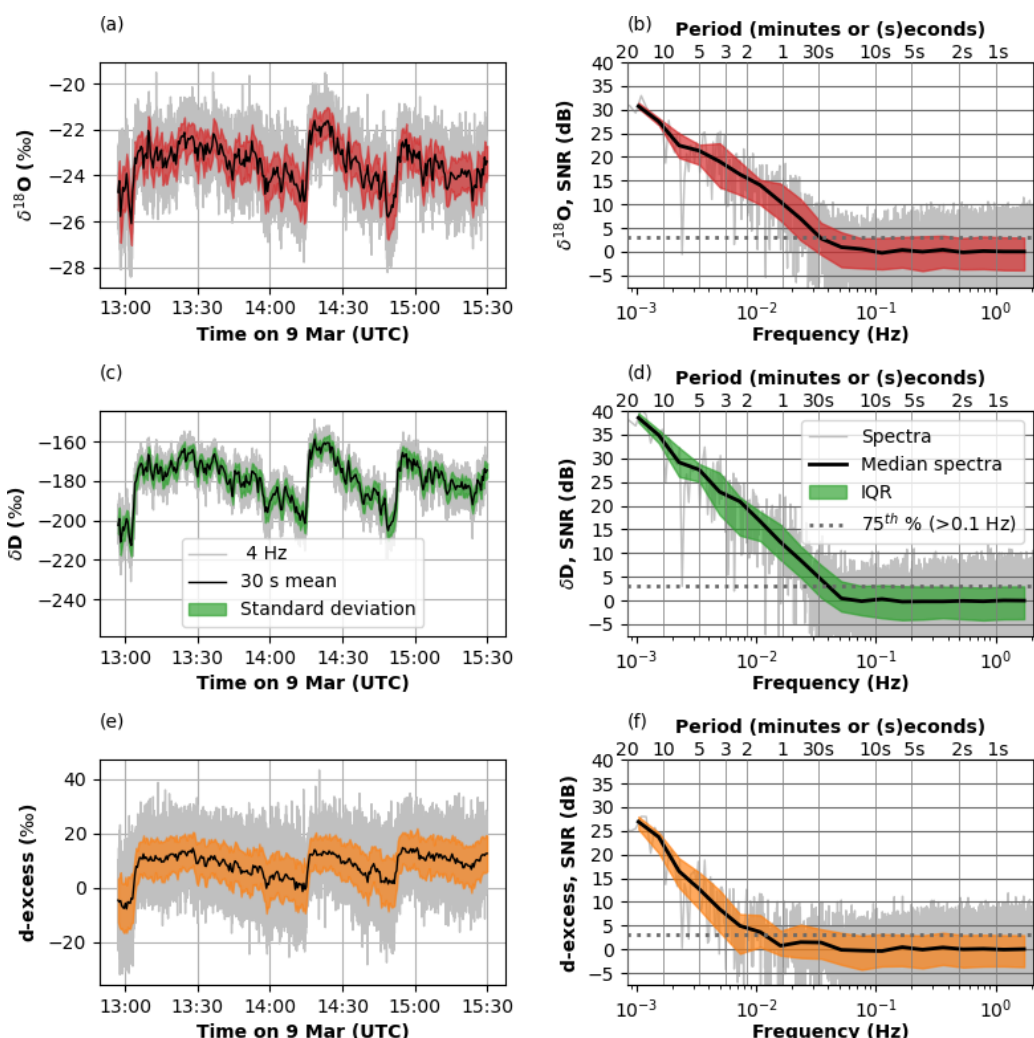
Figure 9. Resolving isotopic signals during the profiling period on 9 March 2020, from 12:57 to 15:30UTC. (a) The 4Hz δ 18 O signal (gray), with the 30s mean (thick black) and standard deviation of the same (colored shading). (b) The fast Fourier transform of δ 18 O (gray), expressed as a signal-to-noise ratio. Black line is the median of the resulting power spectra across 20 logarithmically spaced bins between 8 . 33 × 10 − 4 and 2Hz, while colored shading is the IQR of the bin. Dotted line is the mean of the 75th percentile for frequencies larger than 0.1Hz. (c, d) Same as panels (a) and (b) but for δ D. (e, f) Same as panels (a) and (b) but for